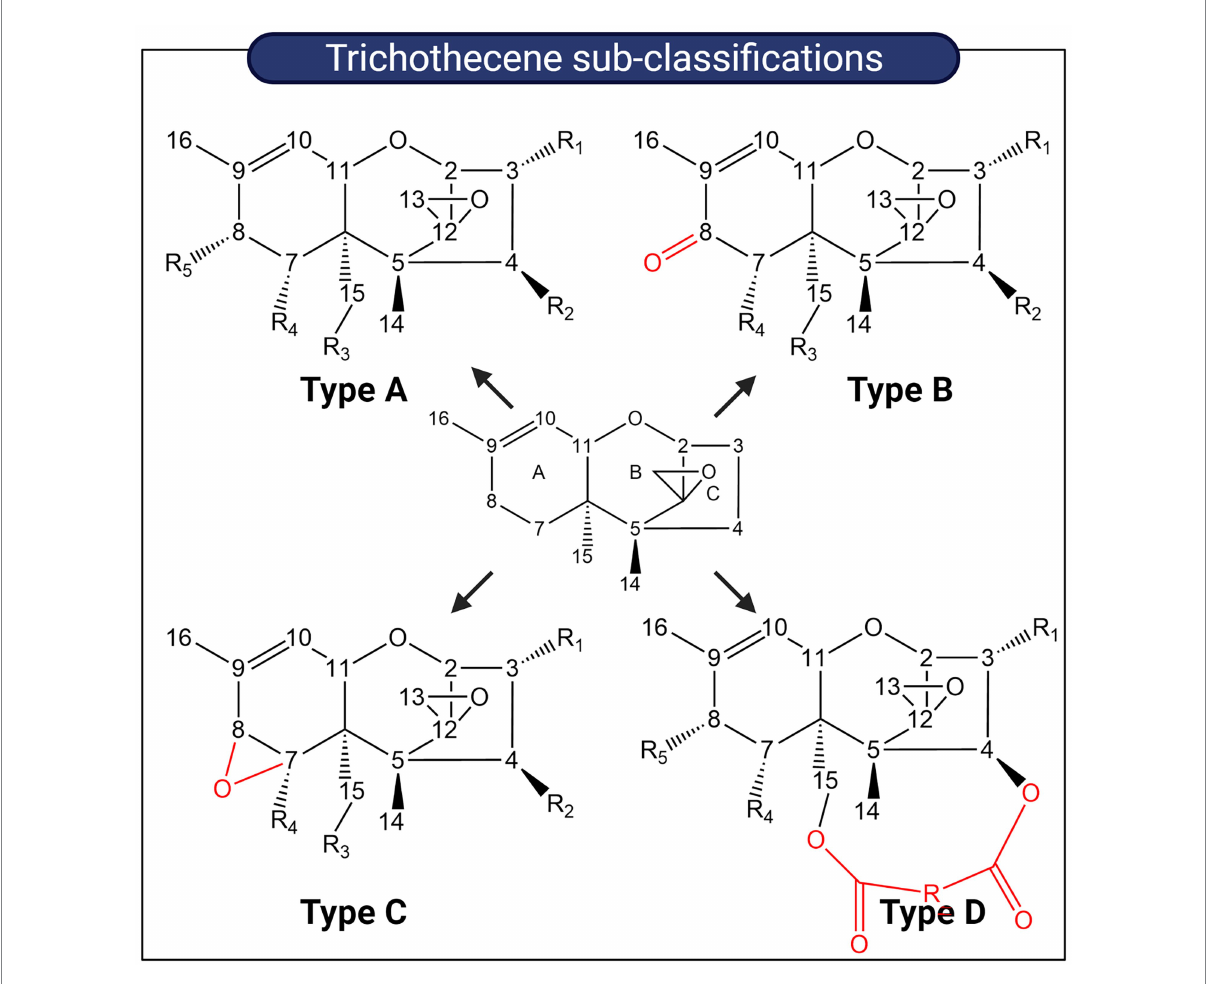
FIGURE 6 Sub-classification of trichothecenes. Trichothecenes can be sub-classified into four groups based on substitution patterns around the EPT nucleus. Key functional groups which distinguish each group from one another are highlighted in